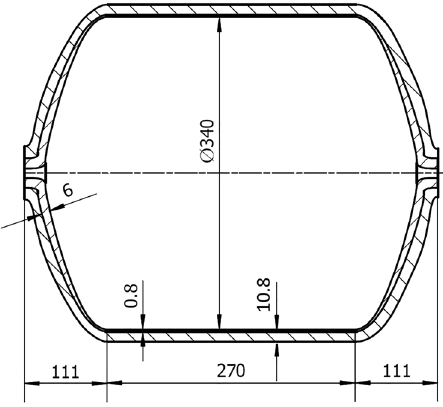
Figure 5: Section view of the pressure